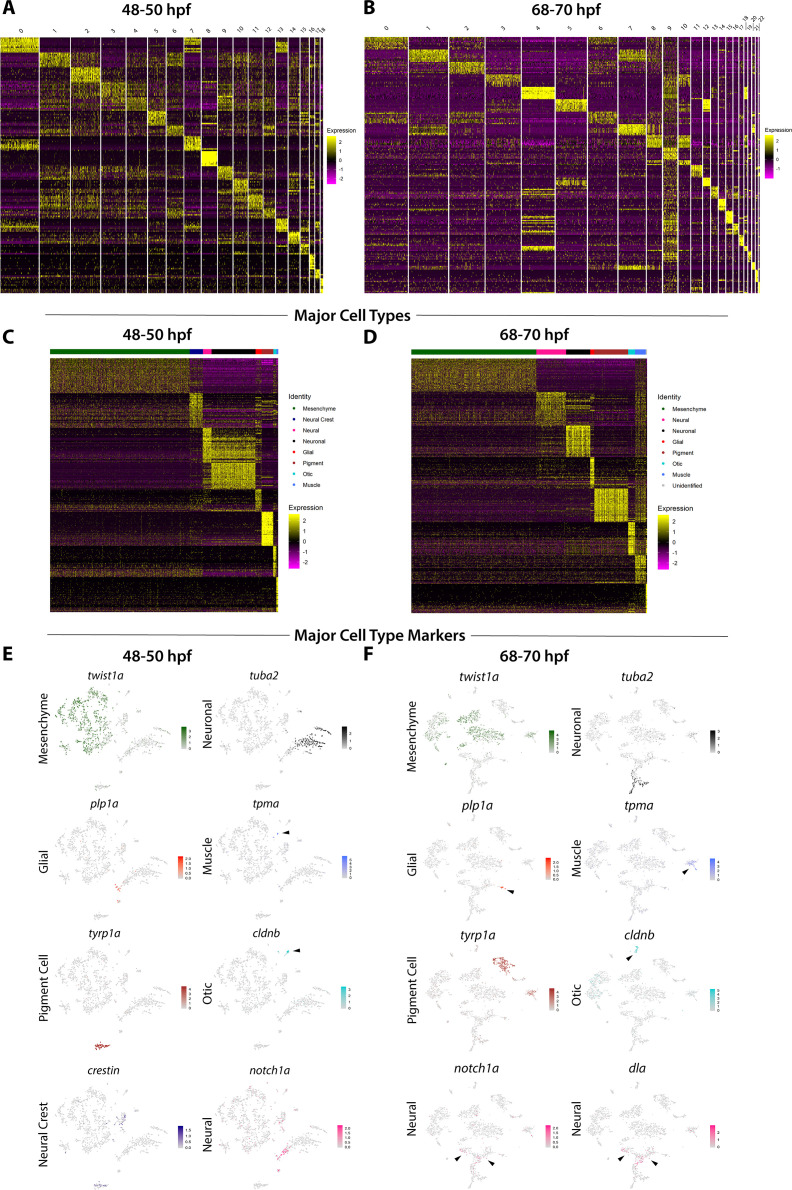
Major cell type annotations among sox10:GFP+ cells.(A,B) Heatmap summarizing the top 10 genes significantly expressed in each cluster, for 48–50 and 68–70 hpf, respectively. Relative expression levels within each cluster is summarized within the color key, where yellow to magenta color indicates high to low gene expression levels. (C,D) Heatmaps summarizing the top 30 genes significantly expressed among the major cell types identified among sox10:GFP+ cells, for 48–50 and 68–70 hpf, respectively. Relative expression levels within each major cell type cluster is summarized within the color key, where yellow to magenta color indicates high to low gene expression levels. (E,F) tSNE plots depicting the major cell type classification representative gene marker for each major cell type category, for 48–50 and 68–70 hpf, respectively. Relative expression levels are summarized within the color keys, where color intensity is proportional to expression level of each gene depicted.